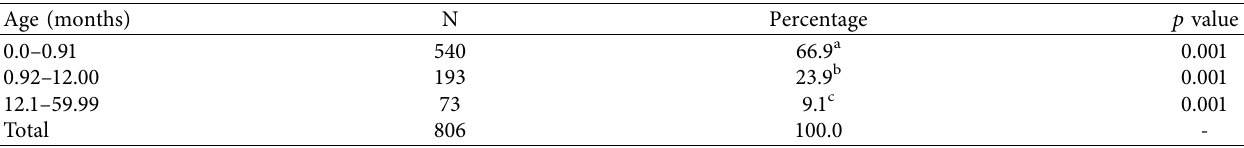
Table 3: Distribution of event or mortality by age among under-five-year-old children born to women living with and not living with HIV between January 2014 and December 2018 in Botswana ( n �